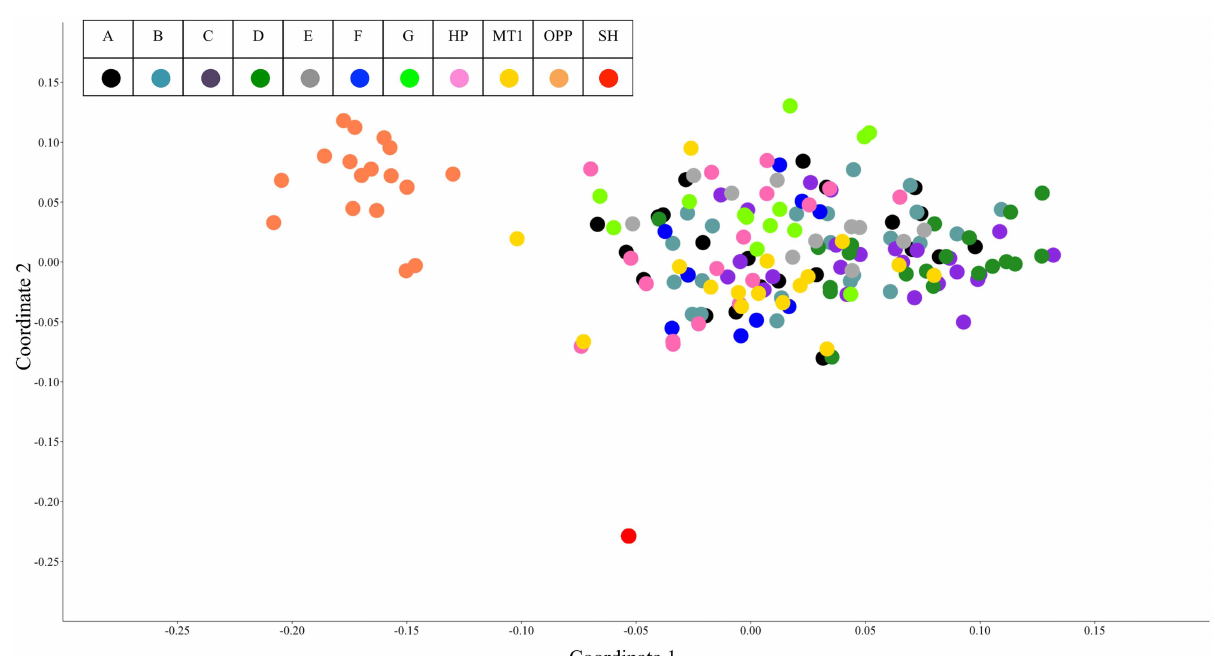
Fig 3. PCoA of local and commercialrelease Poa secunda . Principlecoordinatesanalysis(PCoA) of all local collectionsand releases using a Jaccard similarity index, collectionor release identity are indicatedby dot color accordingto legend.The first axis explains11.14%of the variationin the AFLP profilesand the second explains8.08%, both axes describe19.22% of variation.